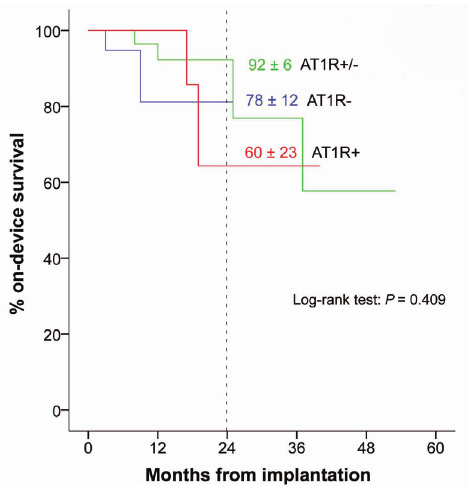
Fig.1. On-device survival of HeartMate II recipients stratified according the presence of anti-AT1R antibodies.